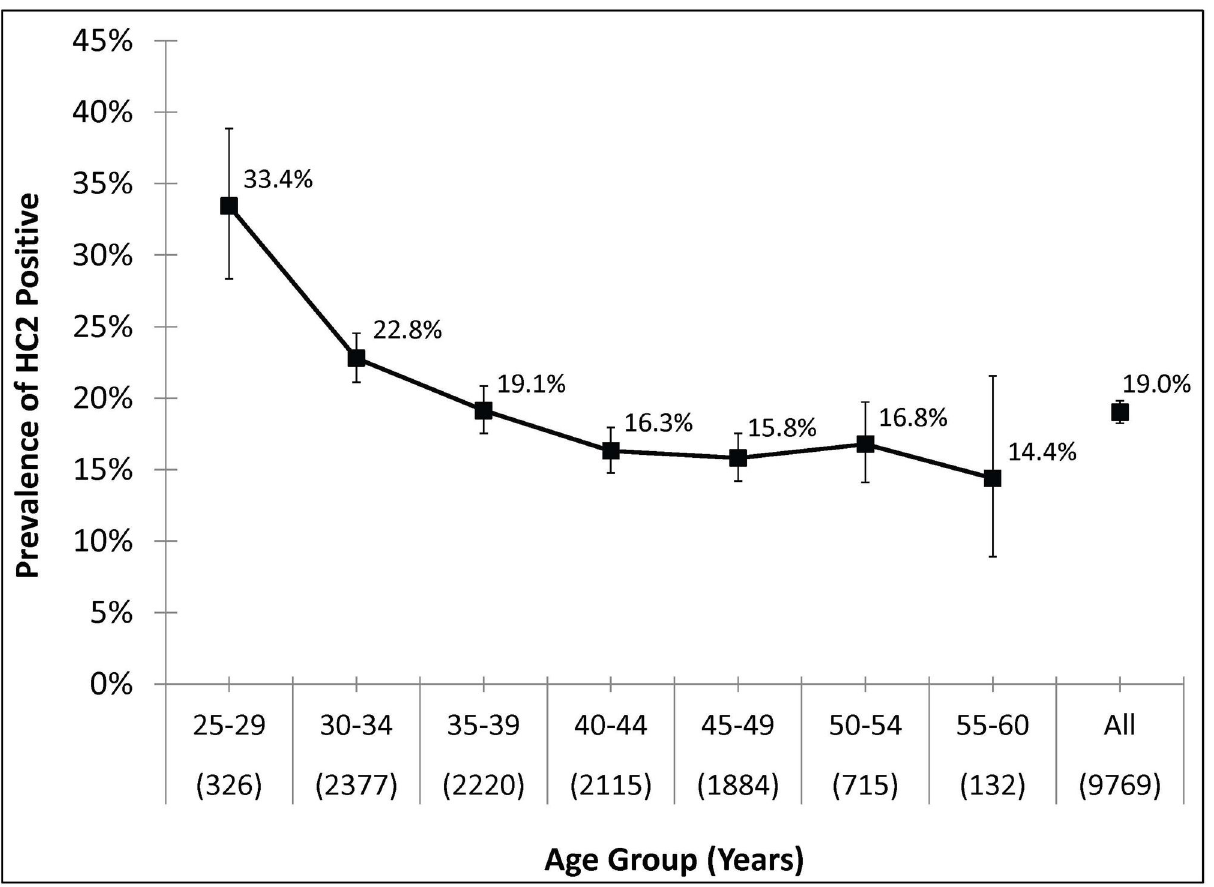
Figure 1. Carcinogenic HPV prevalence by age range. papillomavirus (HPV) DNA as detected by Hybrid Capture 2 (HC2). Bars represent 95% confidence intervals . doi: